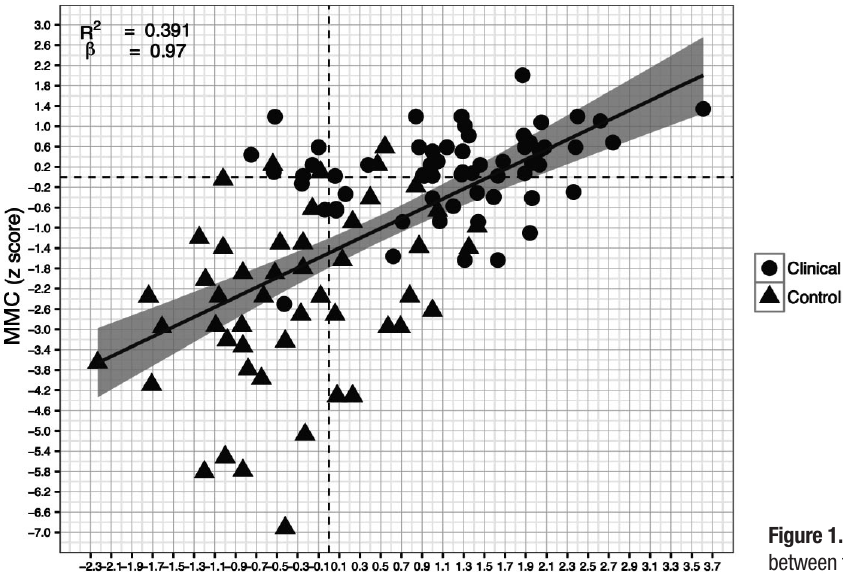
Figure 1. Scatterplot representing the correlation between the CPM and MMC, with dashed lines indicating the 0 point of each